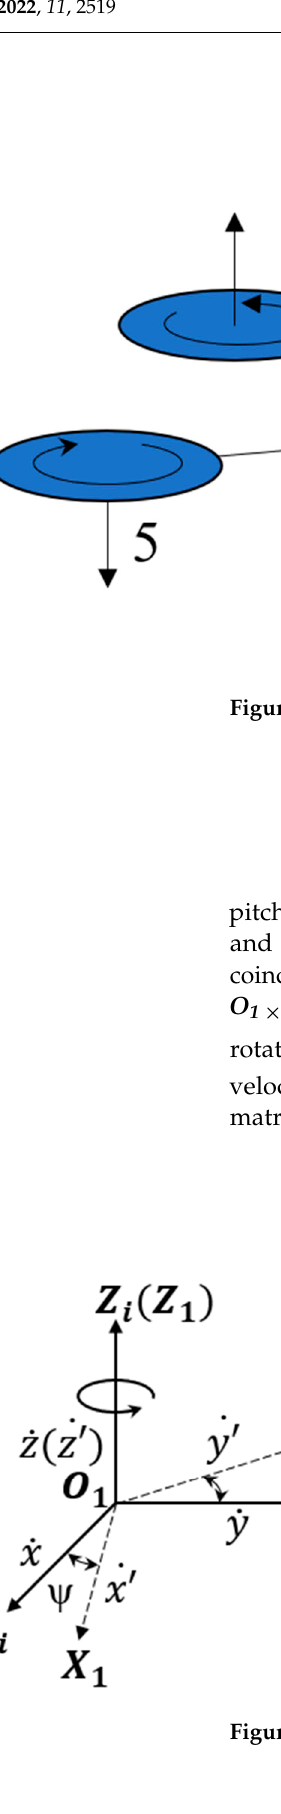
Figure 2. Rotation of hexacopter.